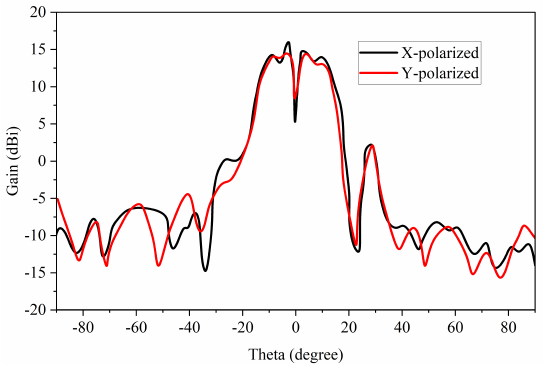
Figure 6. The far-field measured patterns for the suggested TA.